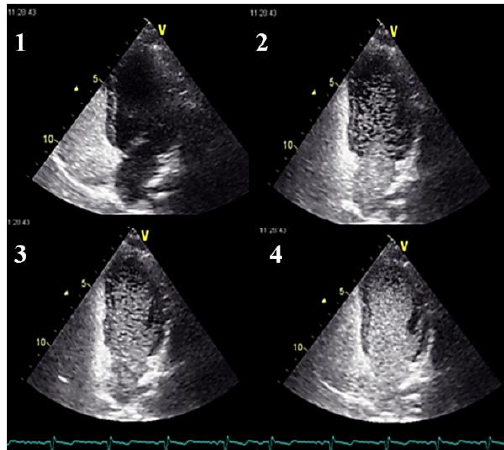
Figure 3. Contrast echocardiography showing progressive opacification with micro-bubbles of the left cavities in images 1 through 4, due to right-to-left intrapulmonary shunting. See also Supplementary Material — Video S1.